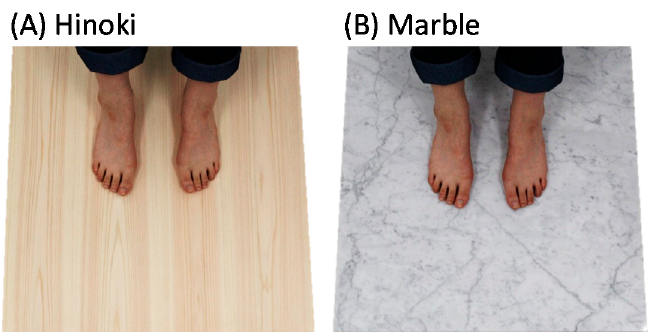
Figure 3. Materials used in the tactile experiment. ( A ) Uncoated Hinoki cypress wood and ( B ) marble.